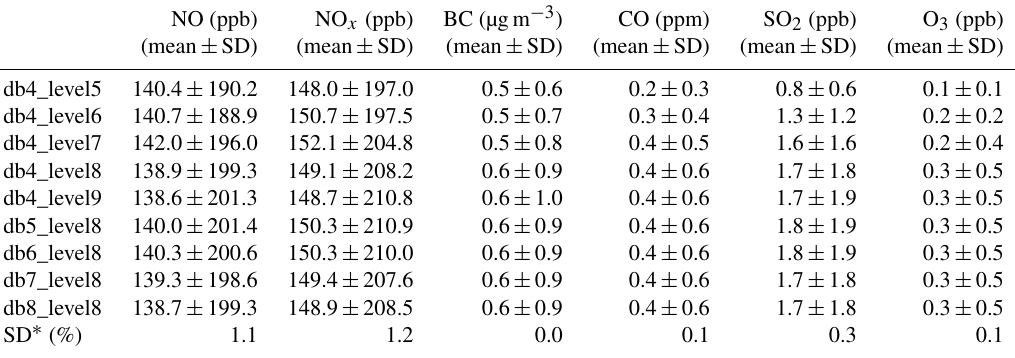
Table 3. The on-road emission concentrations obtained from the WTM for NO, NO x , BC, CO, SO 2 , and O 3 with different mother wavelet functions (i.e. db4–db8) and decomposition levels (5–9